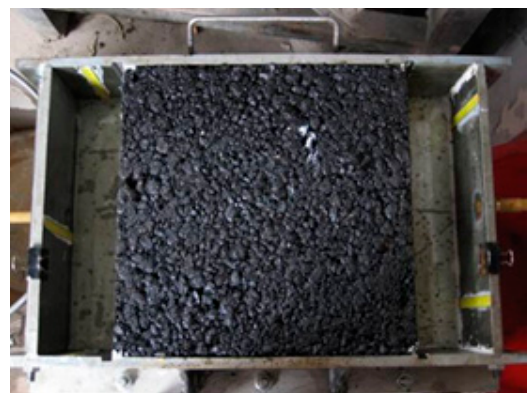
Figure 6. Single-sided infiltration test device for rutted slab.